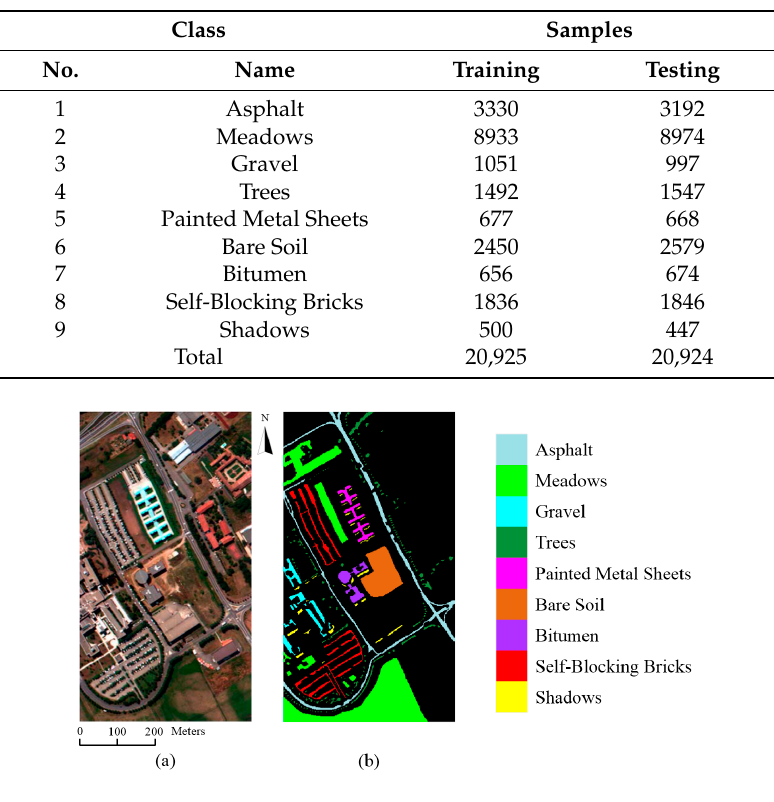
Figure 4. ( a ) False-color composite. ( b ) Ground truth, black area represents unlabeled pixels.